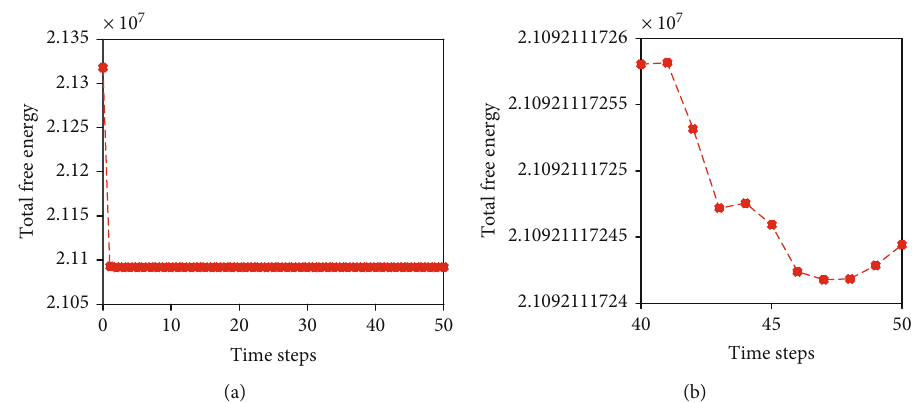
Figure 6: Total energy pro fi les of the classical model in example 1.